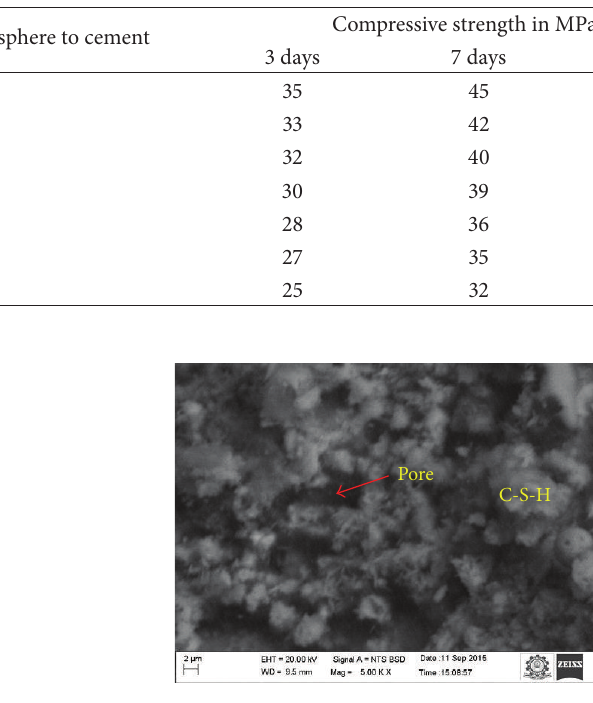
Figure 4: SEM image for SFCS10 specimen.